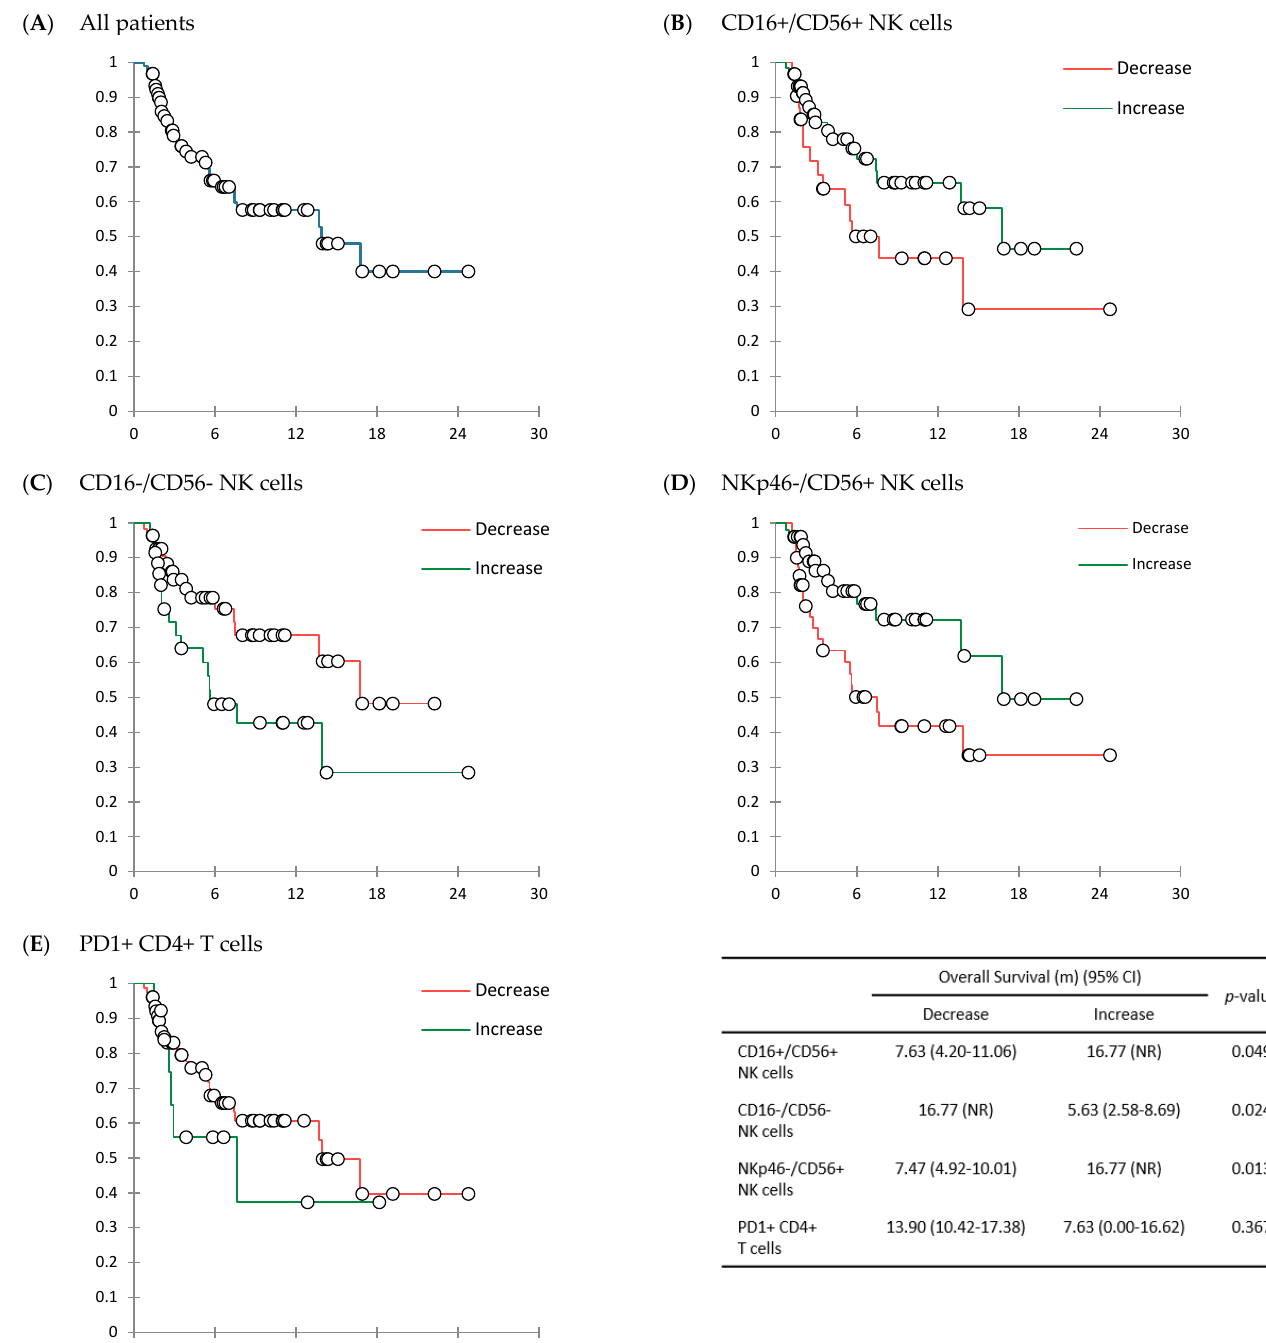
Figure 3. Kaplan Meier curves showing overall survival (OS). OS in all patients ( n = 90) ( A ). OS comparison according to the changes in immune cell fraction; CD16+/CD56+ NK cells ( B ), CD16 − /CD56 − NK cells ( C ), NKp46 − /CD56+ NK cells ( D ), and PD-1+ CD4+ T cells ( E ). Abbreviations: NR, no reached.